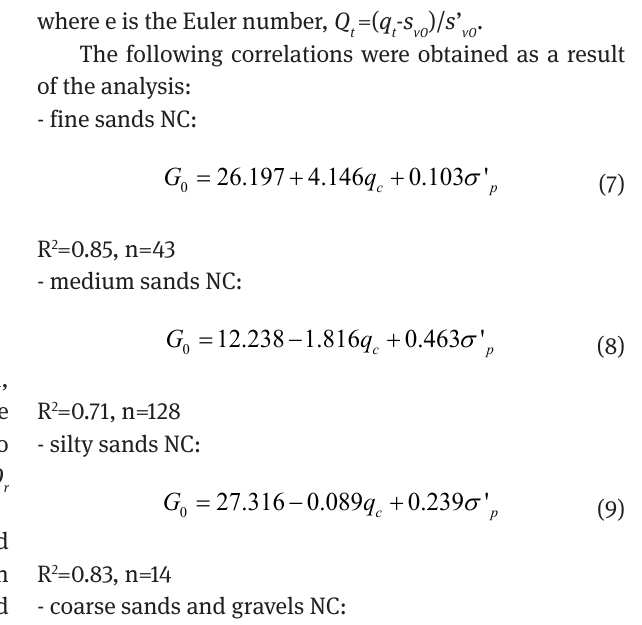
and cone resistance 0